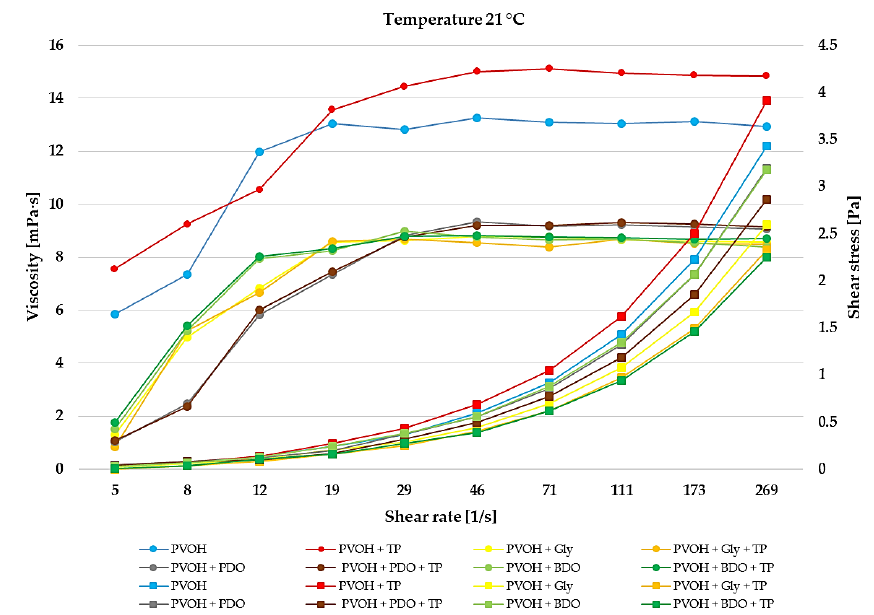
Figure 4. Shear viscosity and shear rate of biofilms at 21 °C temperature. The reported mean values with standard deviation (±) are available in Supplementary Material 3.